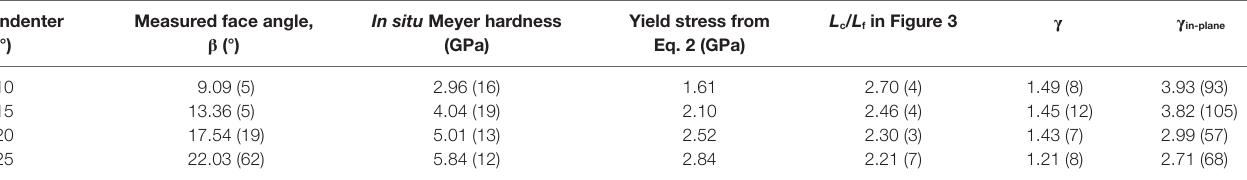
The number in parentheses is the numerical value of the standard uncertainty referred to the corresponding last